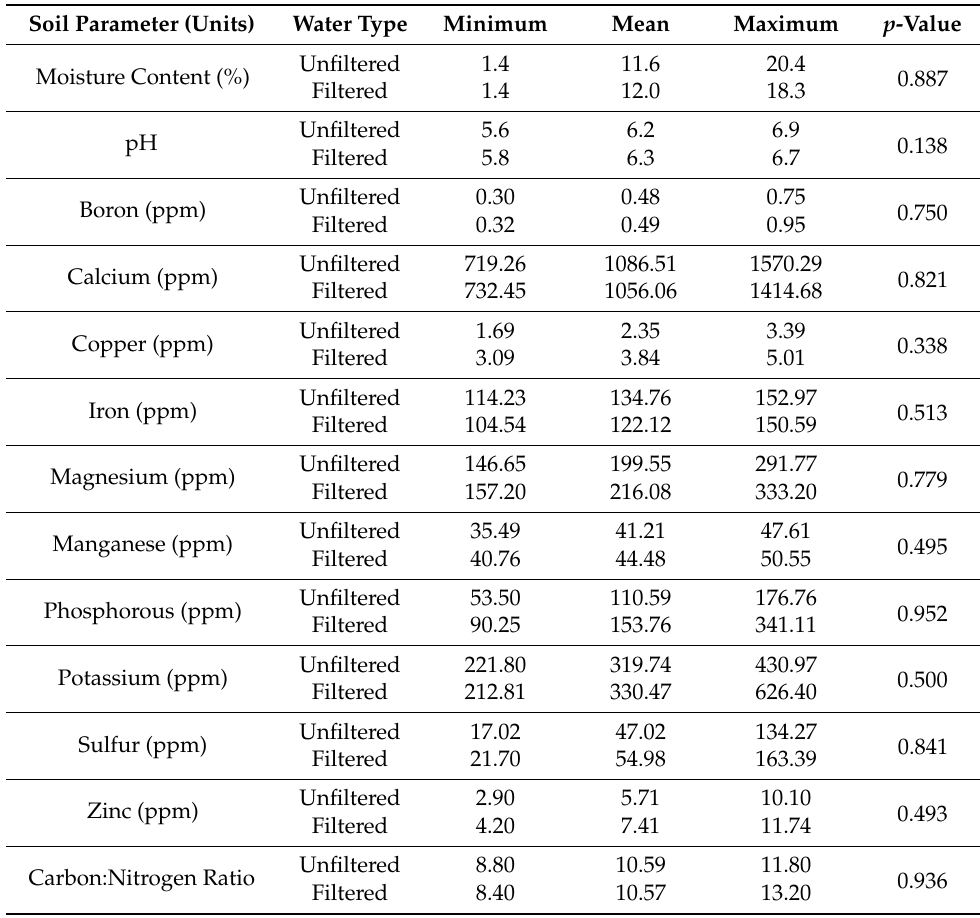
Table 3. Physicochemical parameters of soil in plots irrigated with unfiltered and filtered water collected before and after each irrigation event. The minimum, mean, and maximum values of parameters are displayed by irrigation water